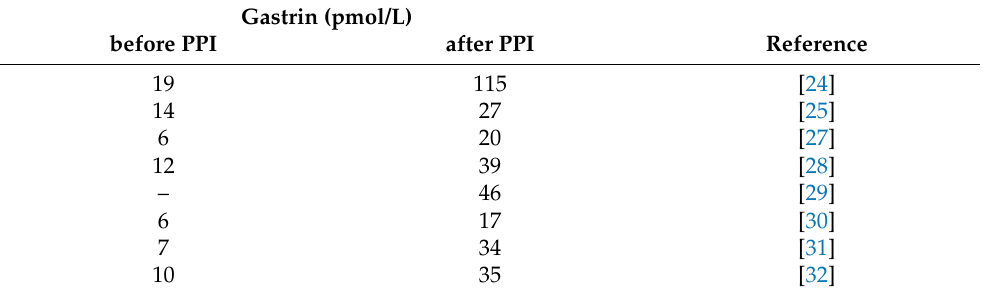
Table 3. Mean concentrations of gastrin in plasma before and after treatment with proton-pump inhibitors